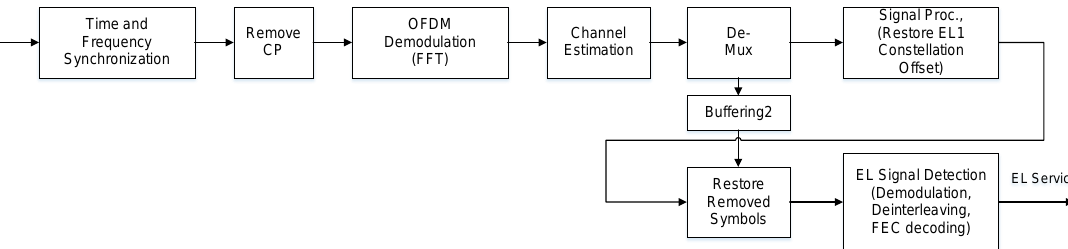
Figure 8. The receiver structure with the direct interference cancellation (DIC) detector of the LDM-Ex-FDM scheme.